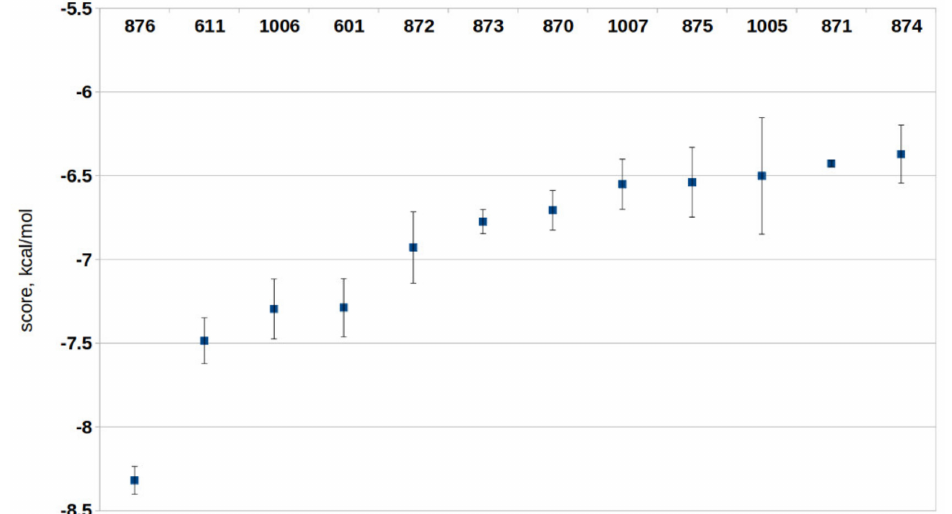
Figure 4. Molecular Docking Results, Average Values from 4 Runs. Compounds are sorted from lowest to highest score values (lowers are better).